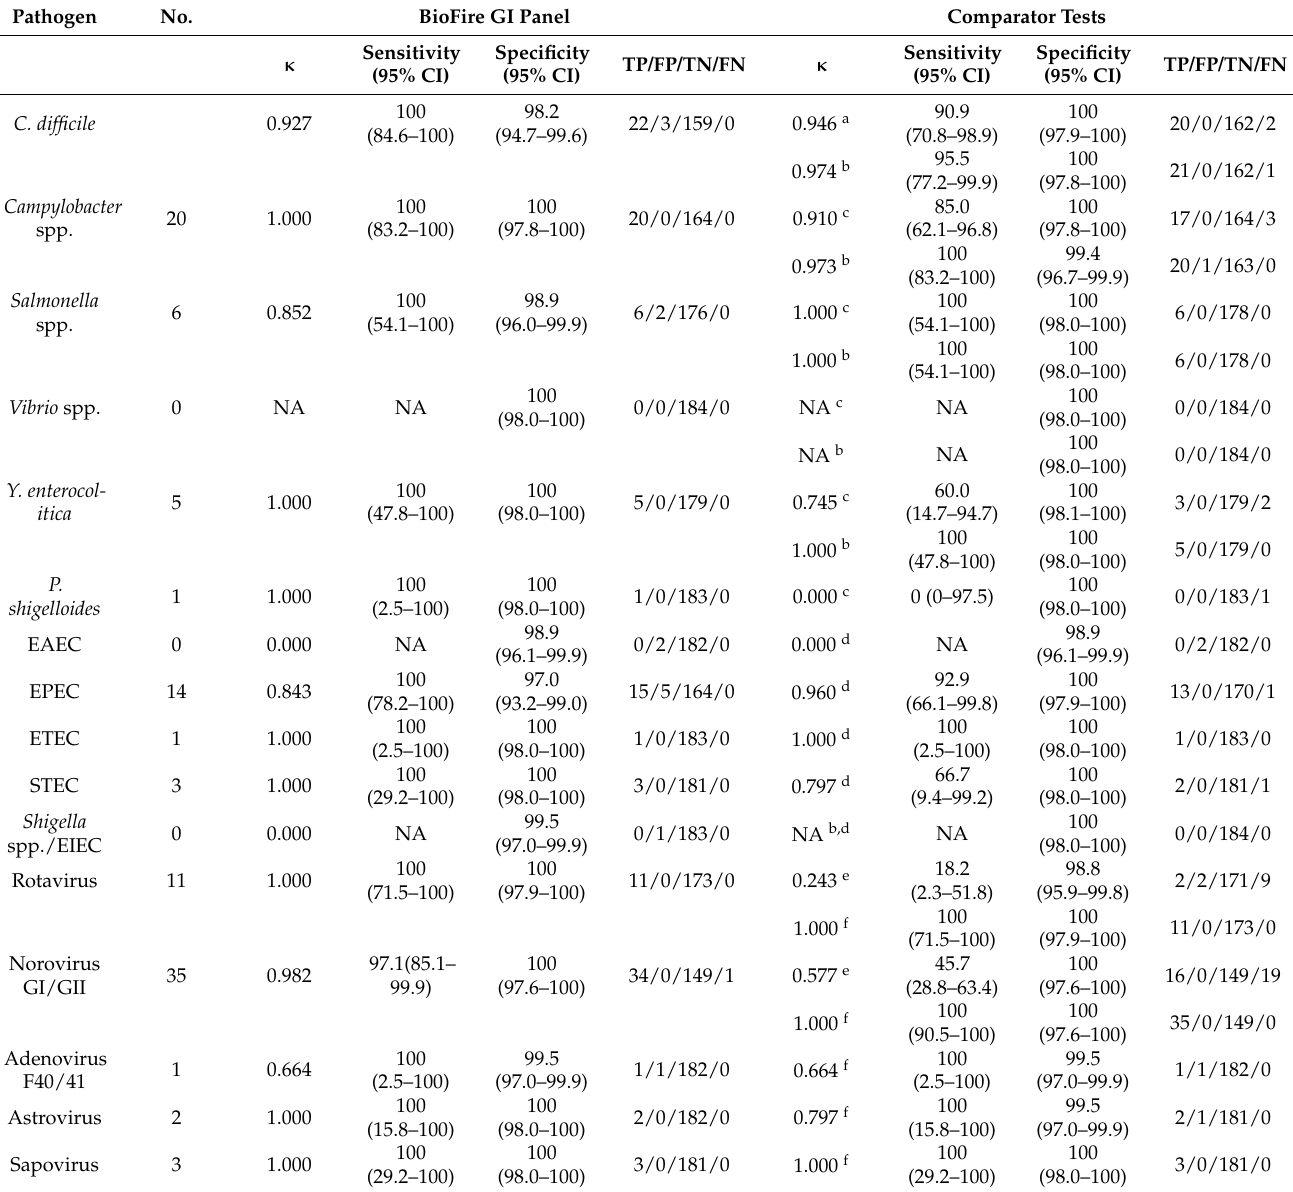
Table 3. Results of the BioFire GI Panel and comparator laboratory